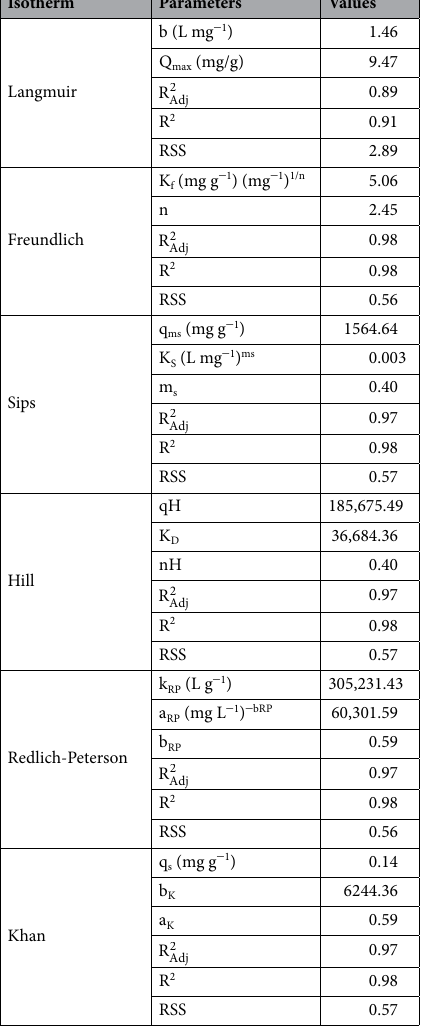
Table 3. Nonlinear equilibrium model parameters for Pb(II) adsorption.